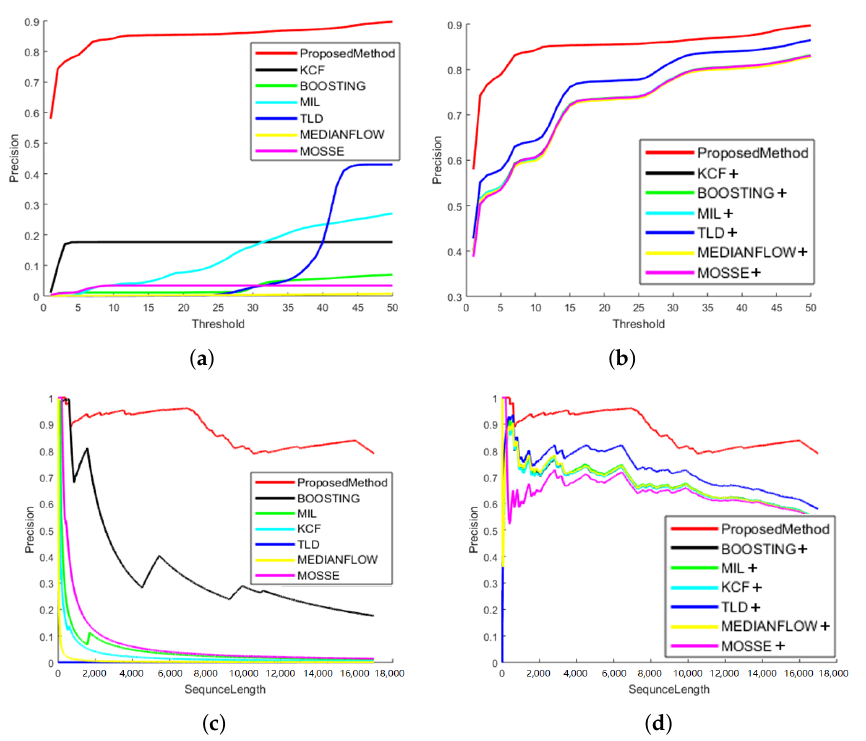
Figure 8. Precision of the tracking results. ( a , b ) The precision with region of interest(ROI) threshold, and ( c , d ) the precision along with the dataset length. ( a , c ) A comparison our method compared to other tracking methods. ( b , d ) A comparison of our method with other tracking method in our adaptive tracking